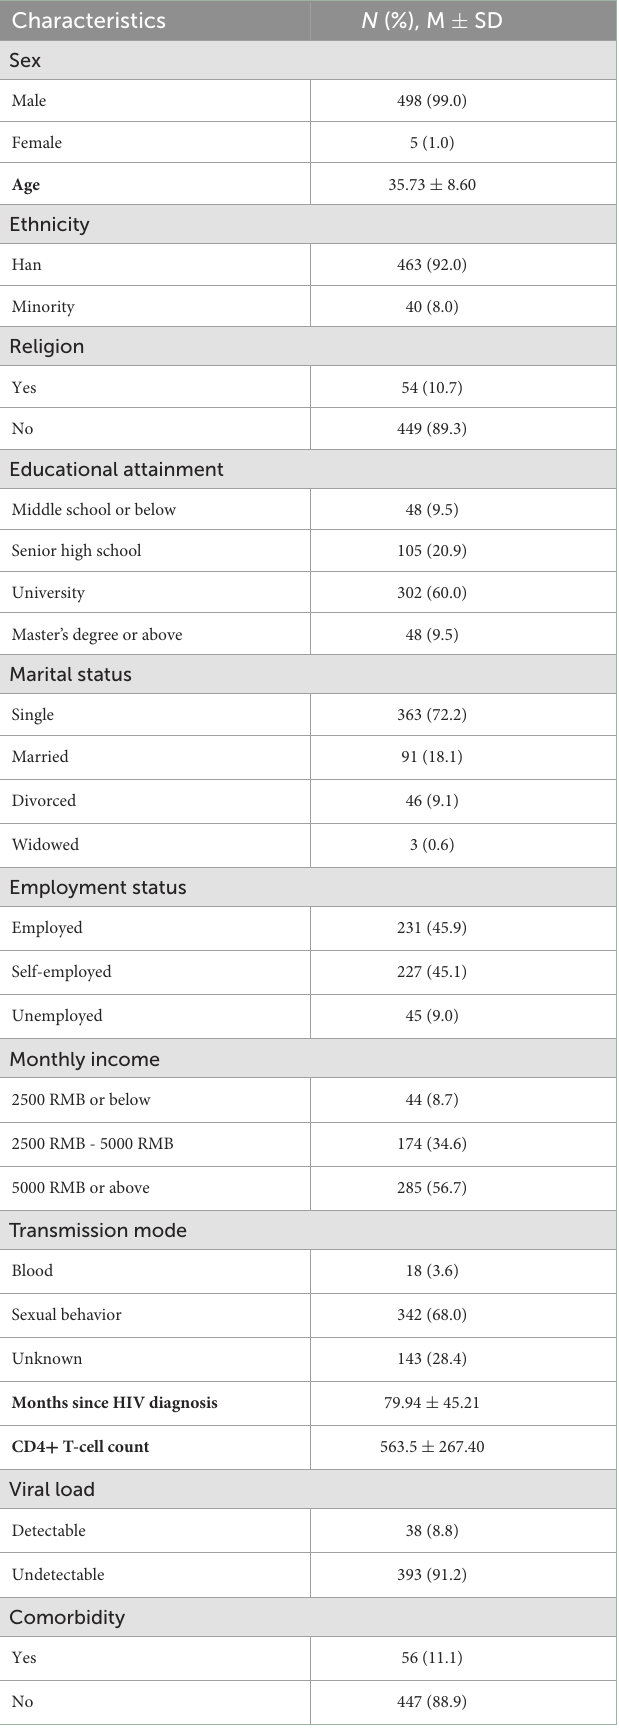
TABLE 1 Participant characteristics ( N =